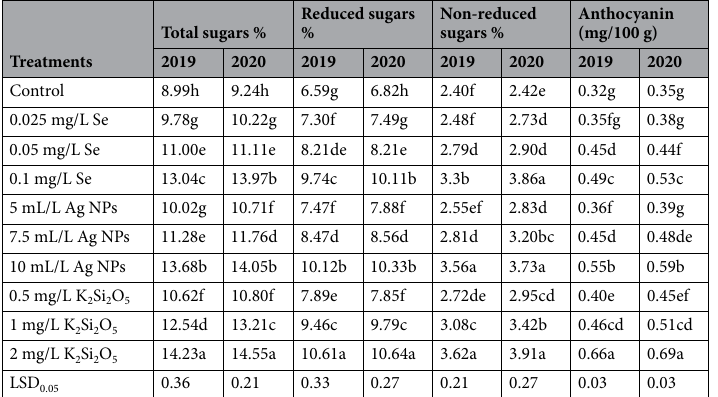
Table 8. Influence of the foliar spraying of Se, Ag NPS and K 2 Si 2 O 5 on fruit content from total, reduced and non- reduced sugars, and anthocyanin of pomegranate cv. Succary during 2019 and 2020 seasons. Means not sharing the same letter(s) within each column are significantly different at 0.05 level of